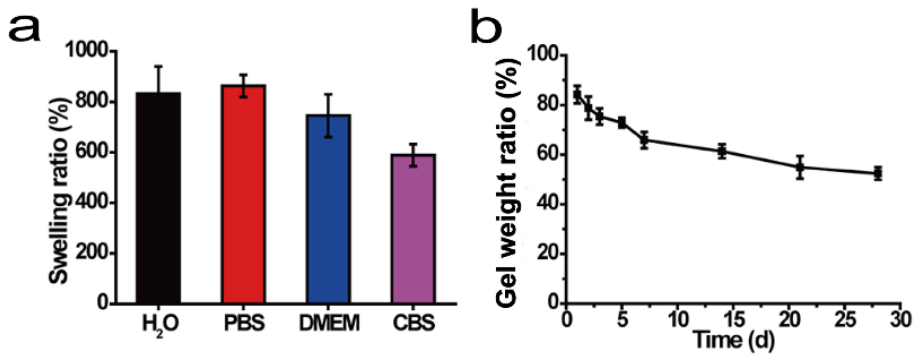
Figure 3. ( a ) Swelling properties of chitosan/polyaniline/laponite (COL) hydrogel in H 2 O, phosphate buffer solution (PBS), Dulbecco’s modified eagle medium (DMEM), and citrate buffer solution (CBS). ( b ) Degradation properties of COL hydrogel in PBS within 28 days.